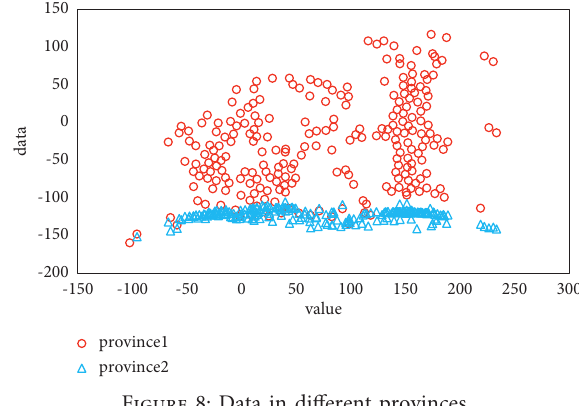
Figure 8: Data in different provinces.